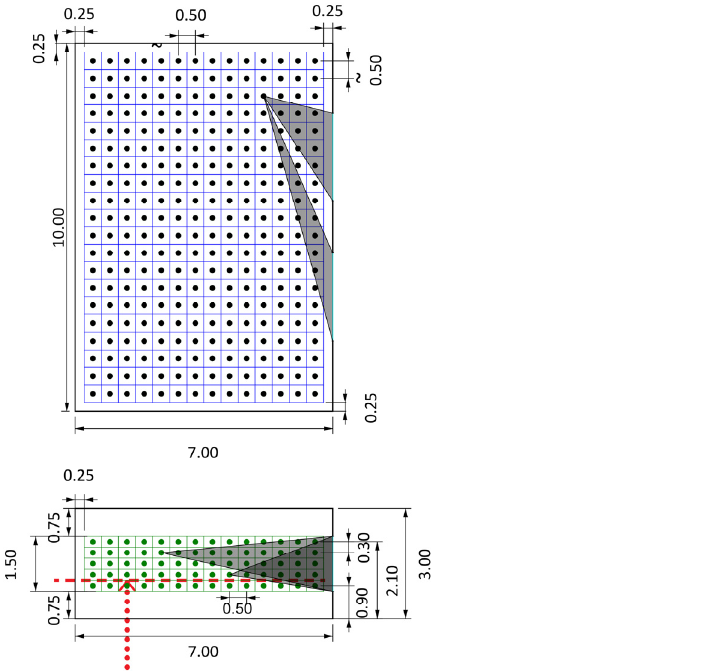
Figure 4. The developed parametric workflow to compute and visualize the view access in space.